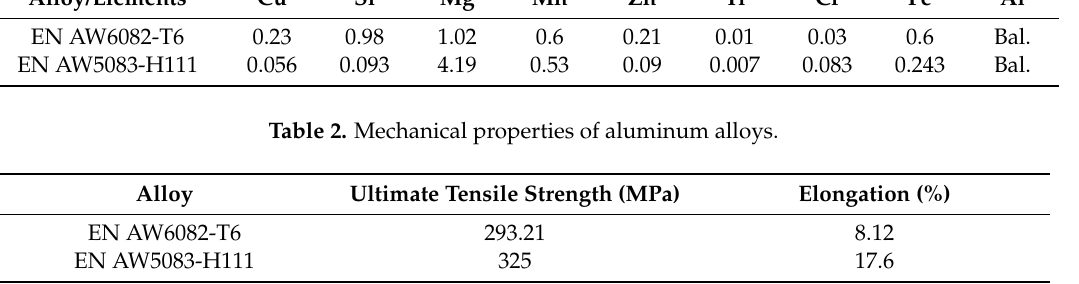
Table 1. The chemical composition of aluminum alloys used in the present study (wt. %).